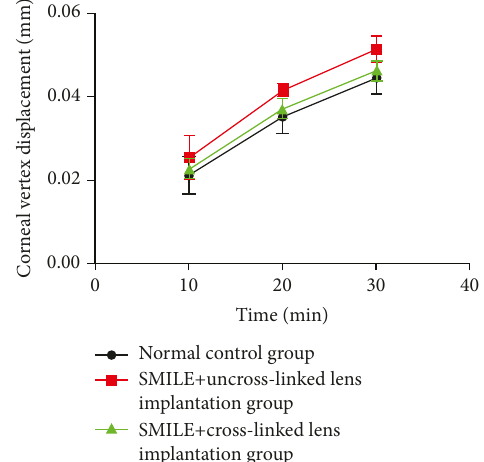
Figure 5: Changes of corneal vertex displacement at different time points. The intraocular pressure (100mmHg) was maintained for 30min to observe the corneal vertex